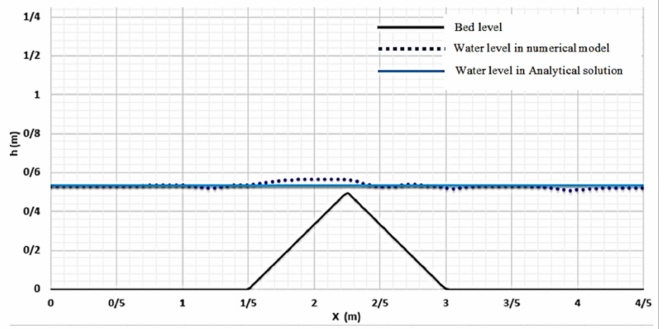
Figure 11. Numerical and analytical results in the test of flow passing barrier and stability above barrier